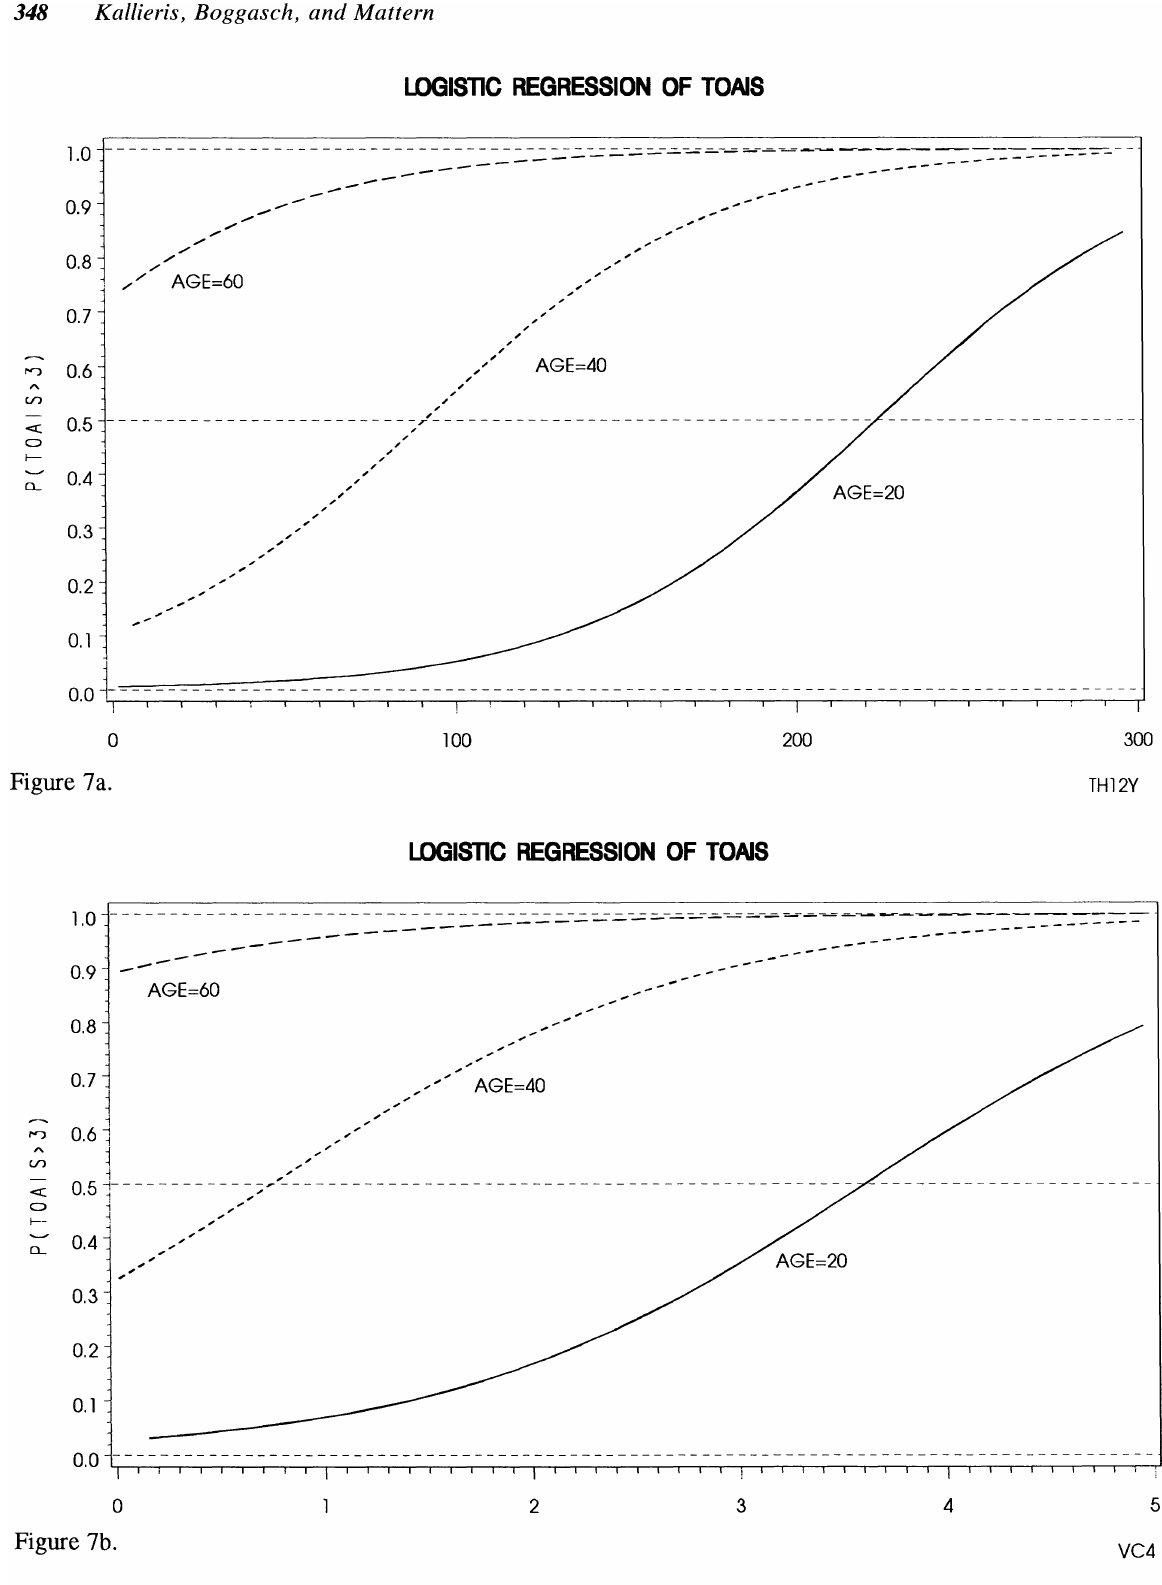
FIGURE 7 Logistic plots of probability of thoracic injury severity vs. the mechanical responses (a) Th12y and (b) VC4 by fixed ages 20, 40, and 60